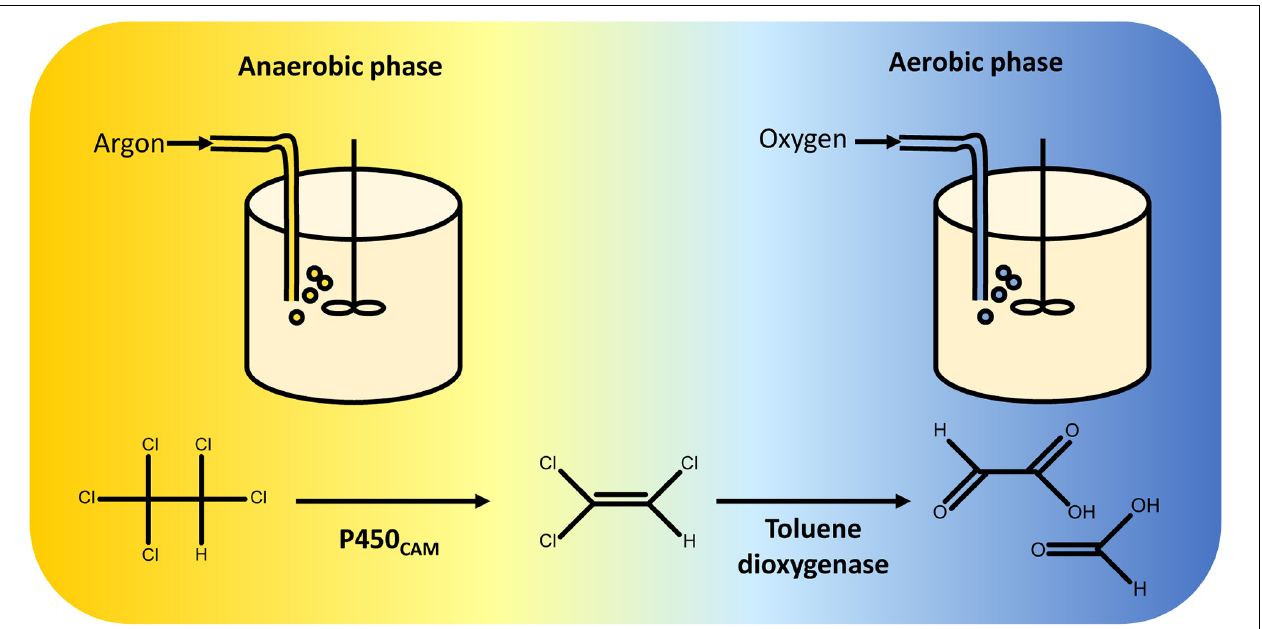
FIGURE 5 | Two-stage fermentation for complete degradation of pentachloroethane. Pseudomonas putida was engineered to overexpress P450 CAM and toluene dioxygenase. Anaerobic conditions were maintained during the first stage of the fermentation, enabling reductive dechlorination of pentachloroethane to 1,1,2-trichloroethylene by P450 CAM . The gas feed was then switched from argon to oxygen, facilitating oxidative metabolism of 1,1,2-trichloroethylene by toluene dioxygenase (Wackett et al., 1994). Toluene dioxygenase oxidises 1,1,2-trichloroethylene to an unstable 1,2-dihydroxytrichloroethane intermediate that decomposes into a mixture of glyoxylate and formate (Shuying and Wackett, 1992), both of which can be incorporated into P. putida central carbon